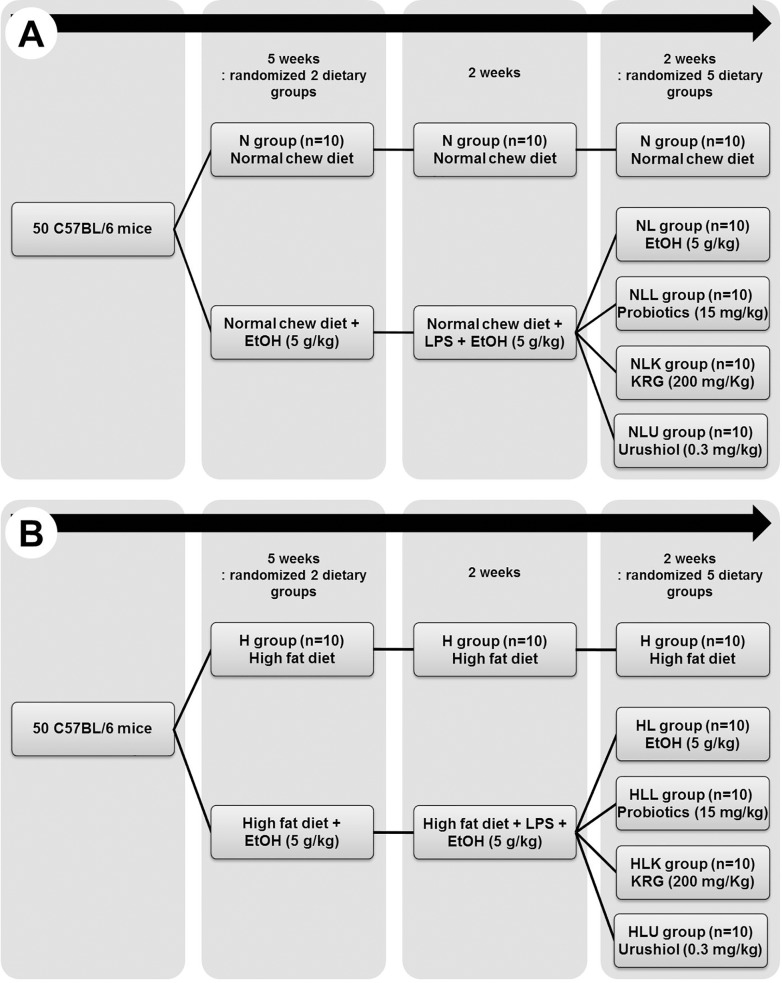
Flow chart of the study design (A) normal chew diet groups and (B) high fat diet groups.n, number; EtOH, ethanol; LPS, lipopolysaccharide; KRG, Korea red ginseng.